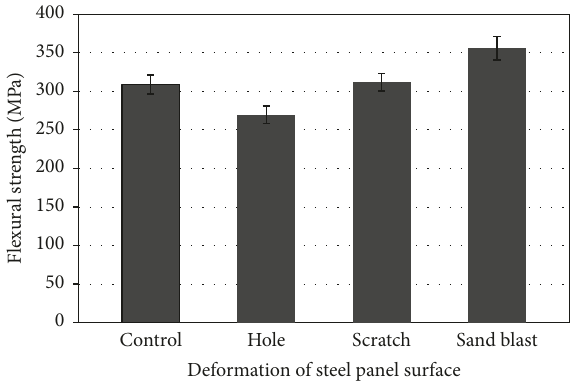
Figure 7: Flexural strength test results of deformation of steel panel